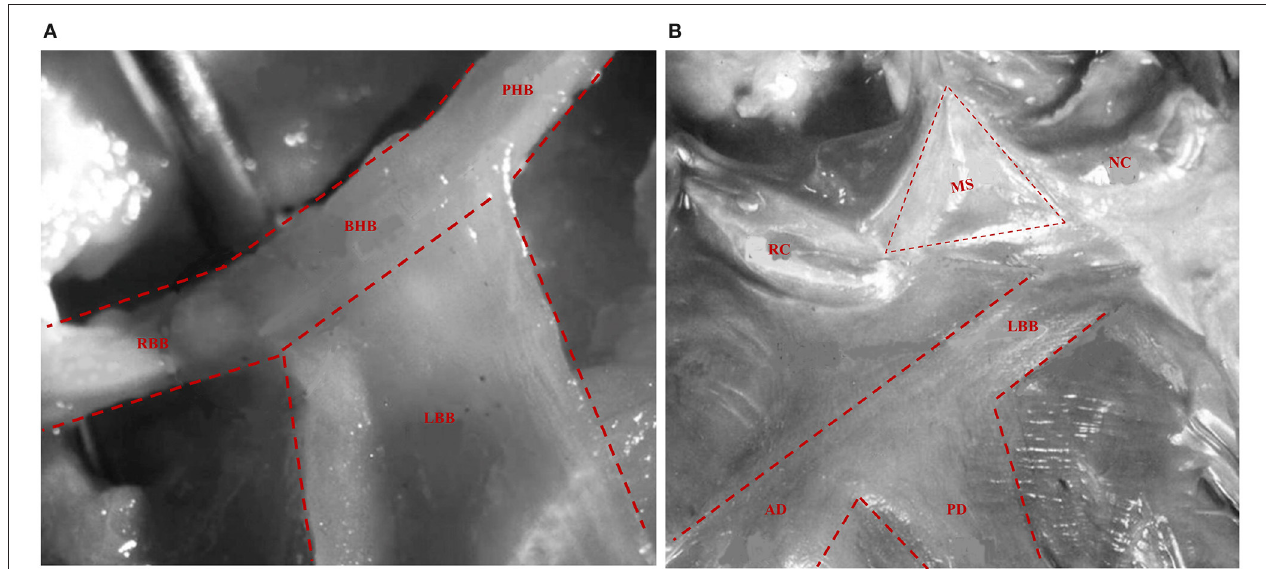
FIGURE 1 | The anatomy of His bundle and LBB. (A) The His bundle comprises two segments: PHB and BHB. LBB originates from the BHB of His located below the MS. The RBB appears as a continuation of the bundle of His after the LBB has been given off. (B) LBB can be seen underlying the endocardium below the MS, which is encompassed between the NC and RC aortic cusps and the summit of the ventricular septum. Then, it produces its two main divisions, AD and PD, both heading the anterior and posterior papillary muscles, respectively (23). LBB, left bundle branch; PHB, penetrating portion of His bundle; BHB, branching portion of His bundle; MS, membranous septum; RBB, right bundle branch; NC, non-coronary aortic cusps; RC, right coronary aortic cusps; AD, anterior division; PD, posterior